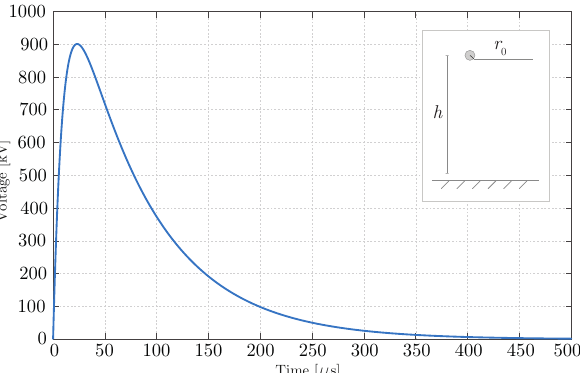
Figure 7. Reference voltage applied to the conductor in the configuration displayed in the inset.